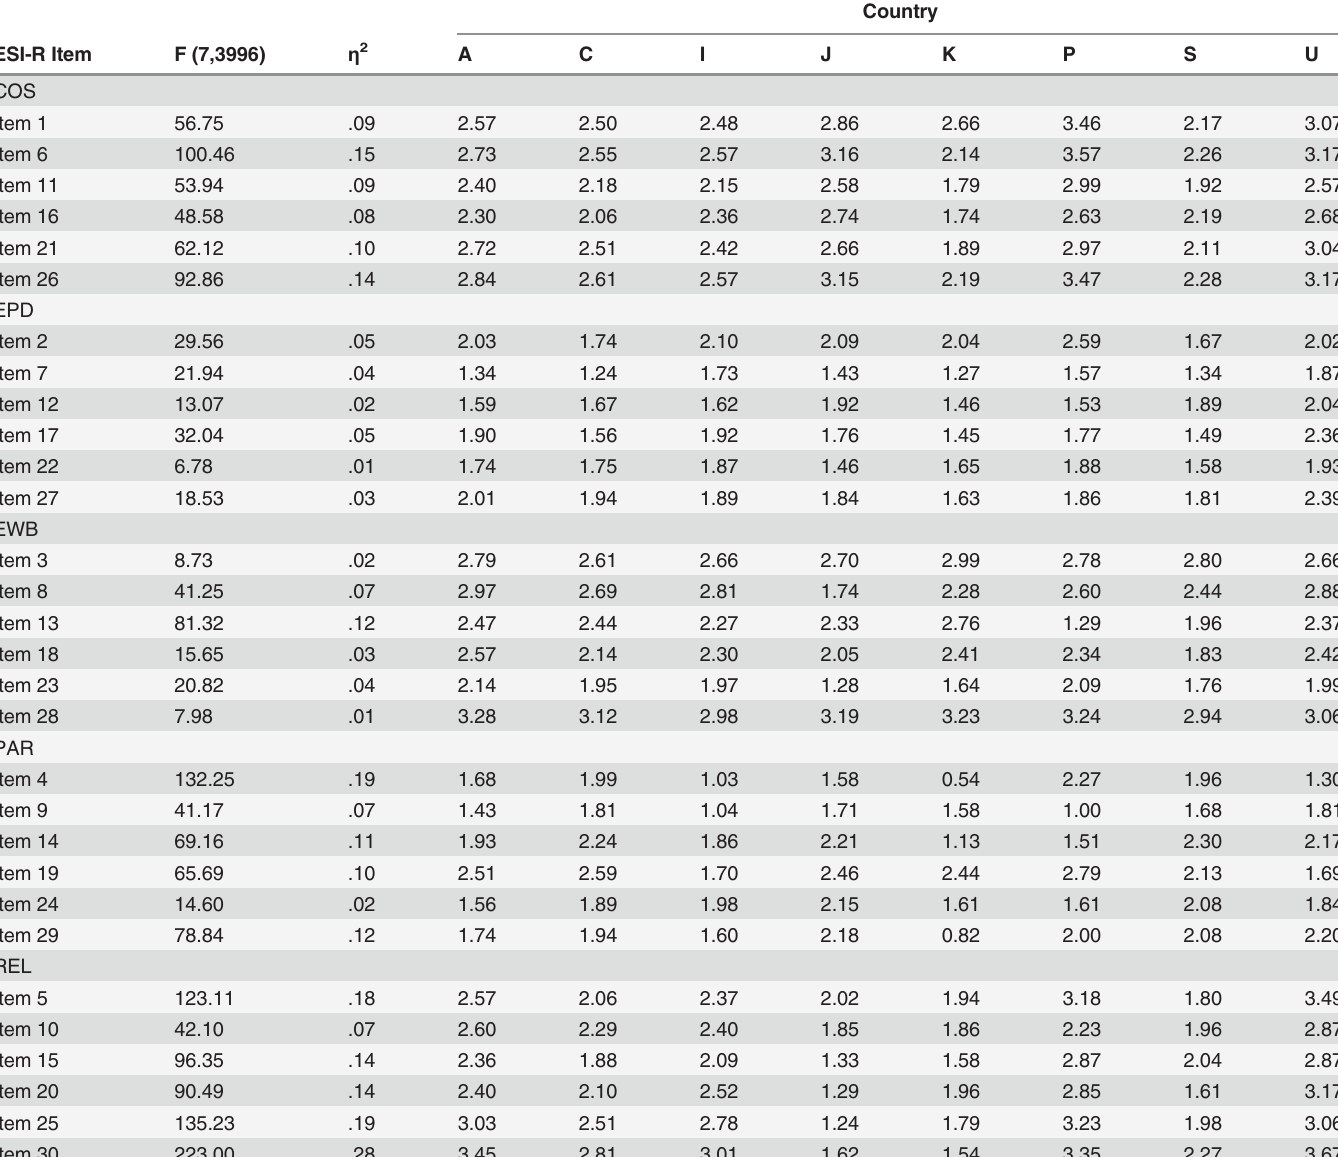
Table 6. One-way ANOVA Results for ESI-R Items as a Function of